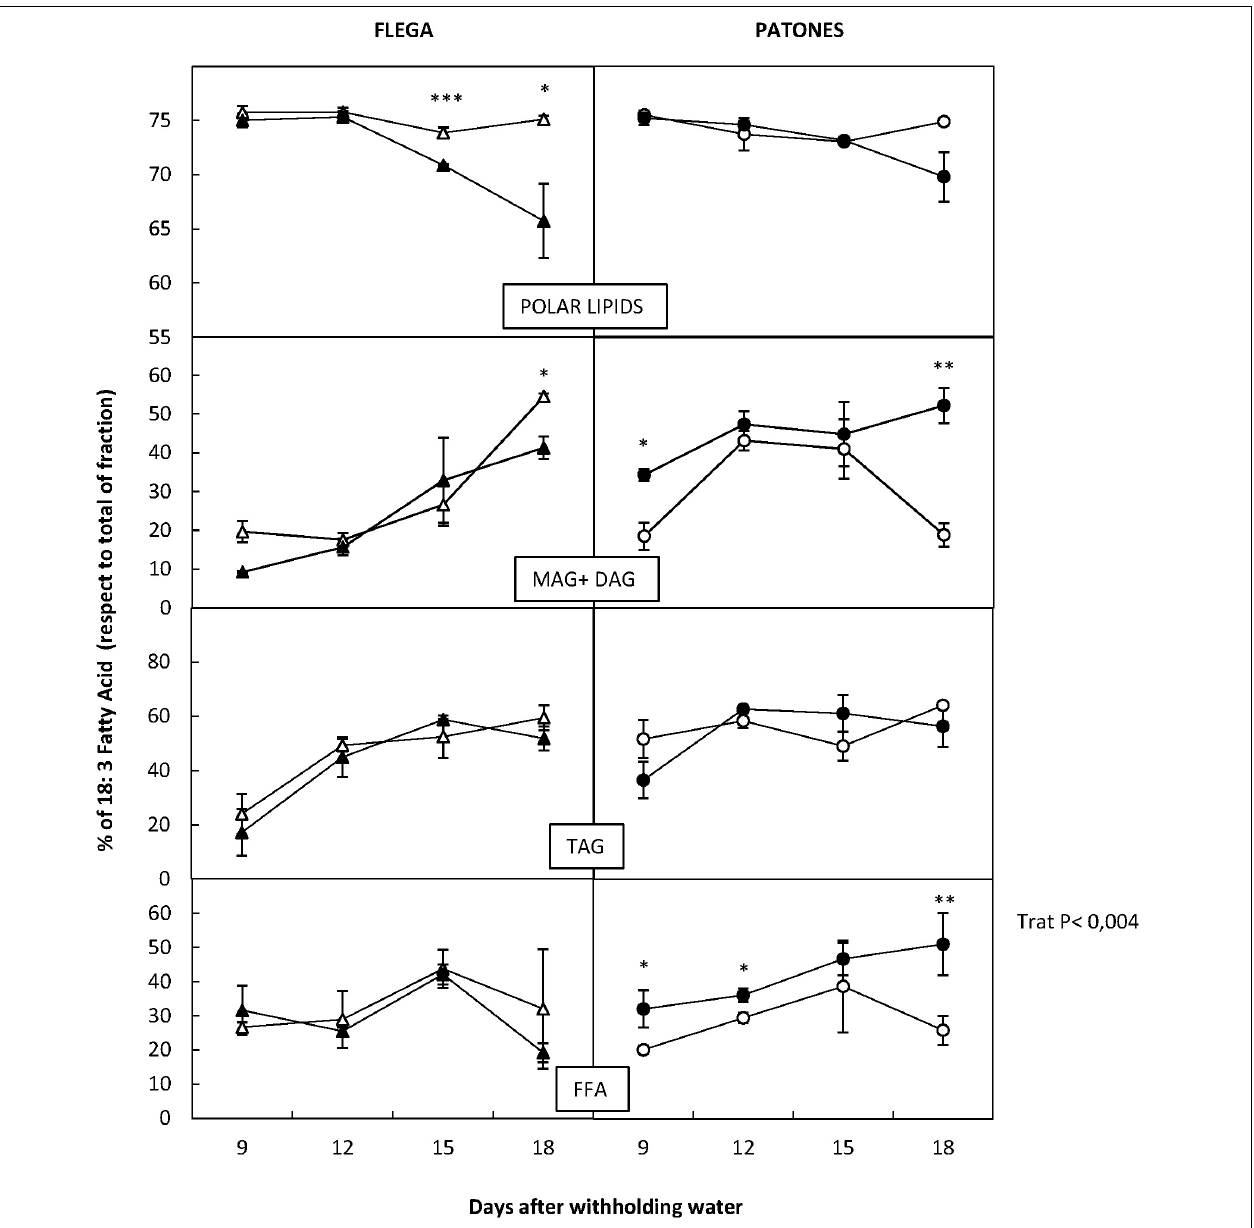
FIGURE 8 | Dynamic of 18:3 fatty acids during drought respect total lipid fraction. Linolenic acid was quantified in drought susceptible Flega (triangles) and resistant Patones (circles) well-watered plants (open symbols) and during a time course of water stress (solid symbols) (9, 12, 15, and 18 days). Data are mean of five replicates ± standard error. ∗ , ∗∗ , and ∗∗∗ indicate significant differences at P < 0.05, 0.01, and 0.001,